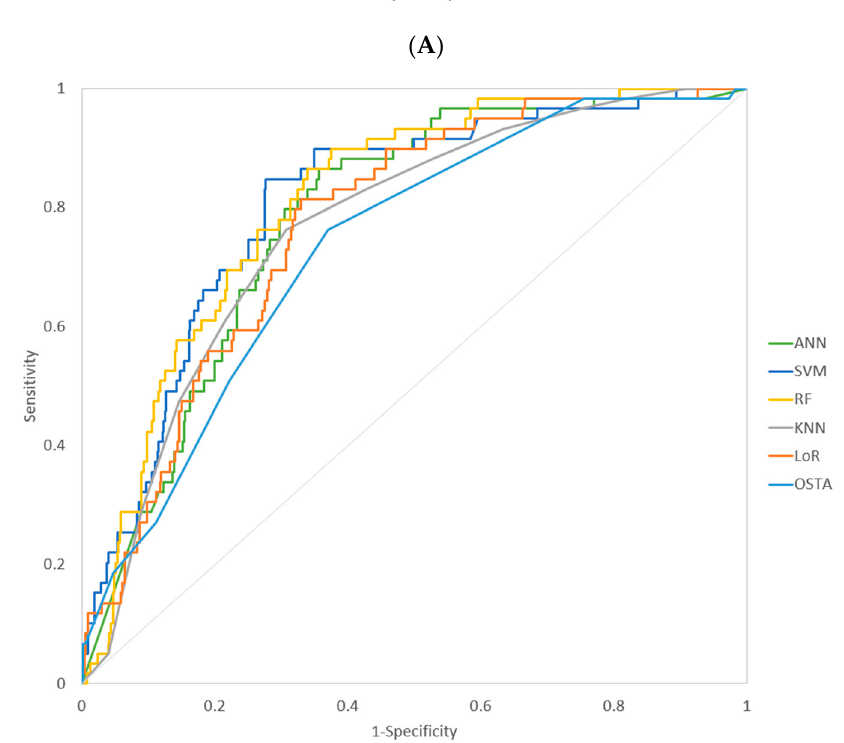
diction of osteoporosis in men. ANN: Artificial neural network; SVM: Support vector machine; RF: